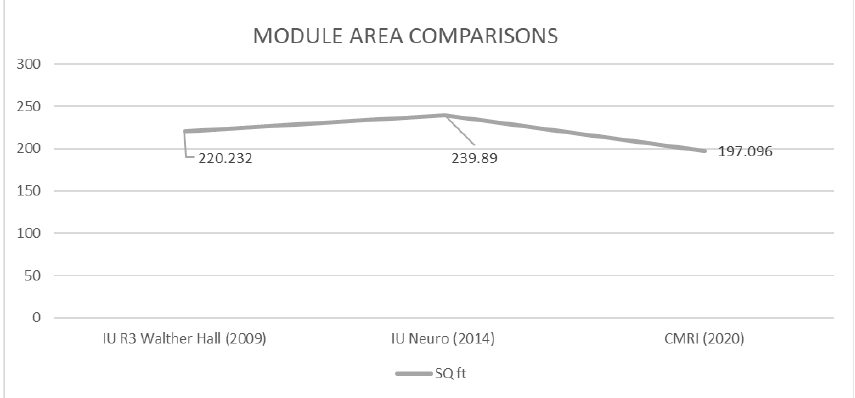
Figure 11 Average space allocation per lab module across the three